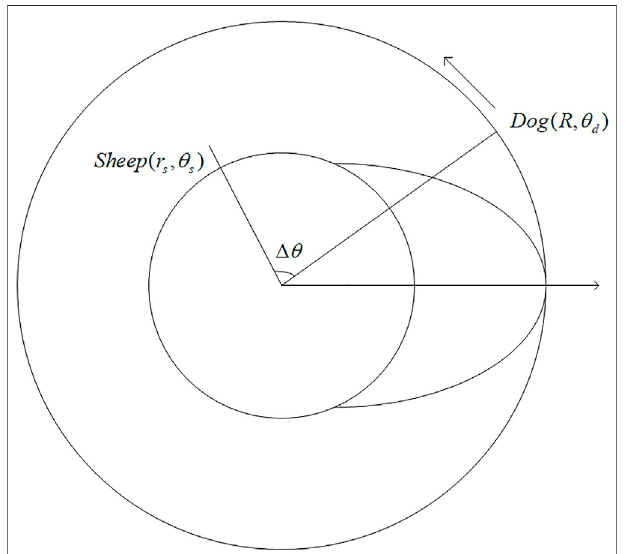
FIGURE 1 | Diagram of the dog ’ s pursuit strategy.